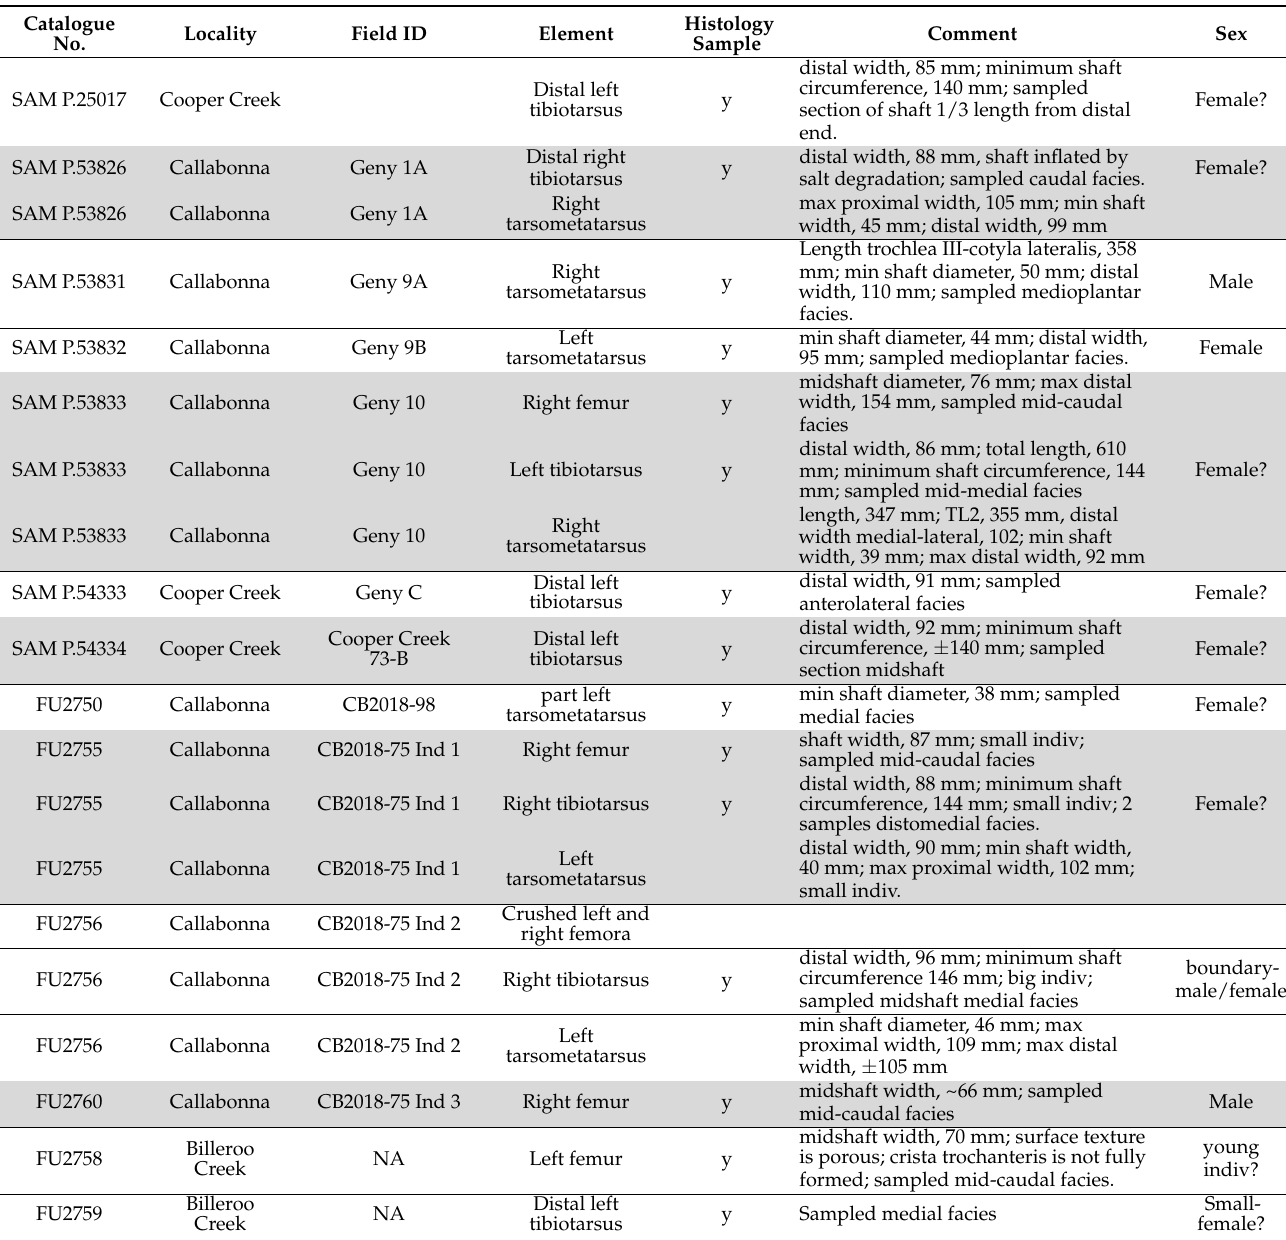
Table 1. Details of the Genyornis specimens sampled. All sites are in South Australia. Unsampled elements of individuals are listed for their ability to reveal the size of the individual. Shading is used to show associated bones of individuals. Catalogue